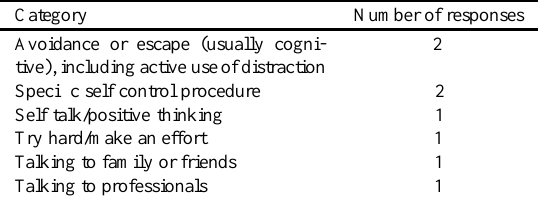
Table 4 Categories of responses to question concerning strategies for